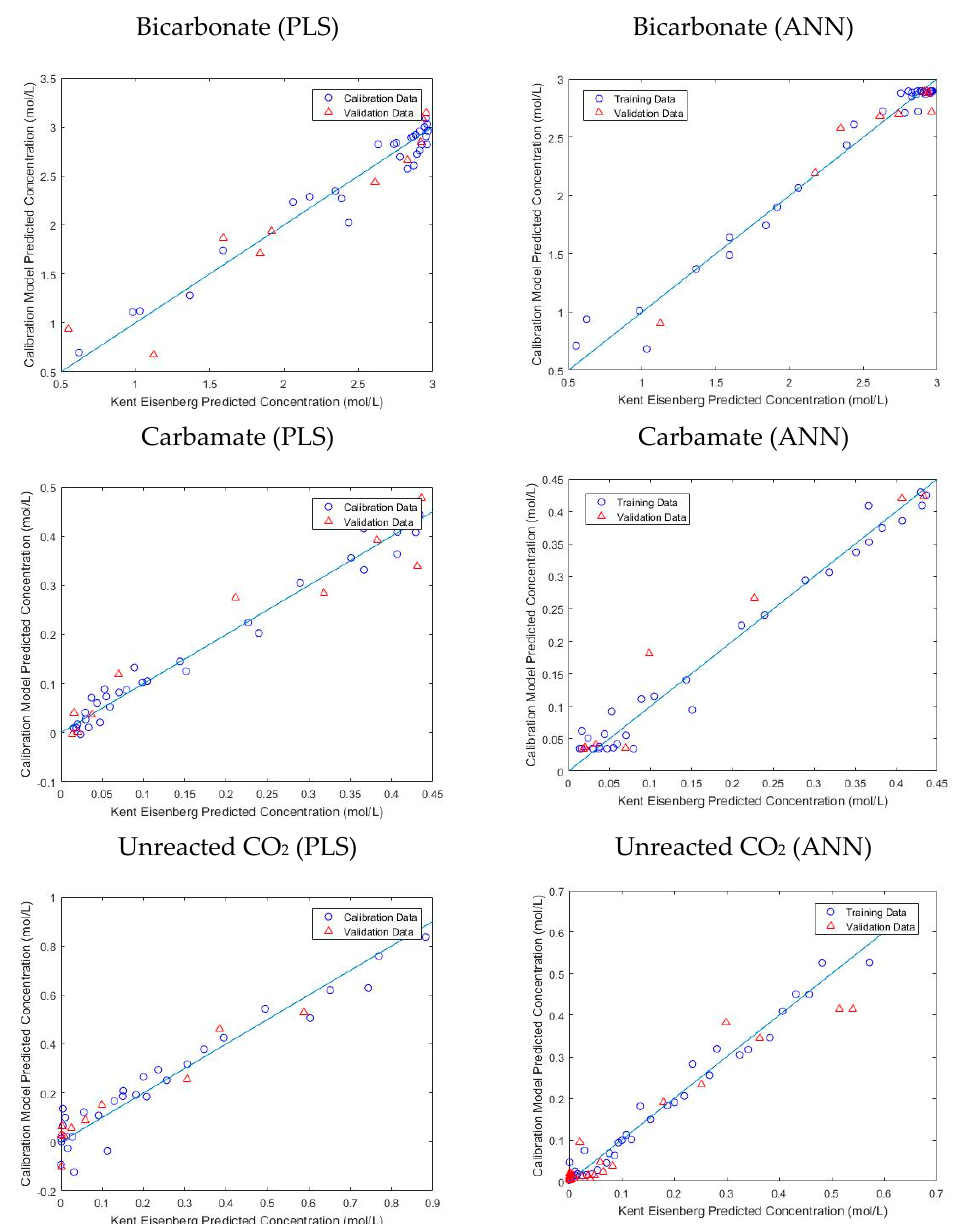
Figure 6. Regression plots from 3 molar MEA calibration models developed using PLS and ANN